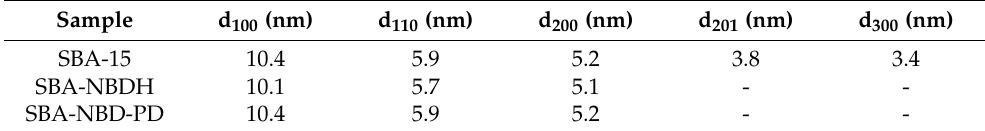
Figure 3. Small angle XRD patterns of SBA-15, SBA-NBDH, and SBA-NBD-PD. Table 2. Interplanar distances of the samples calculated from SAXS results.